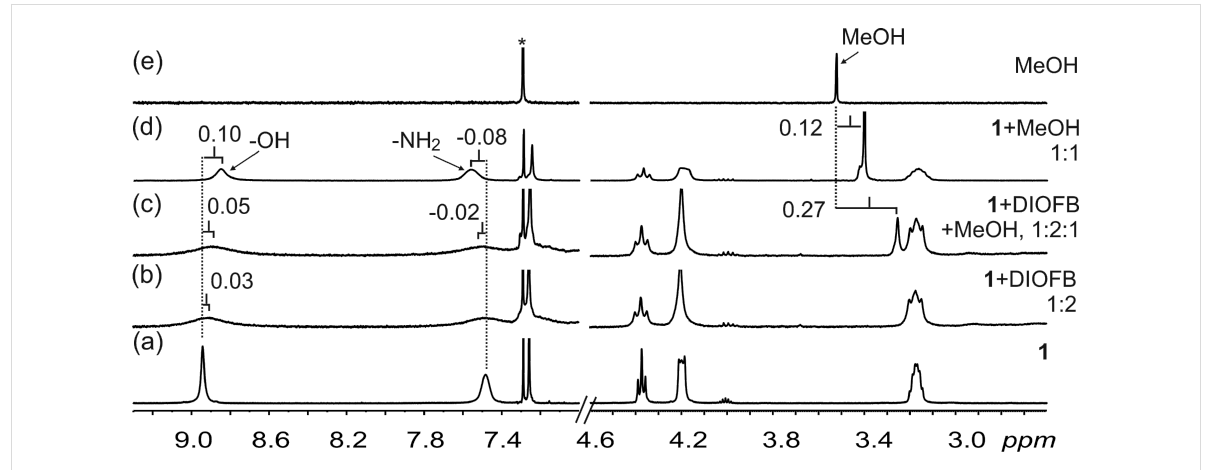
Figure 6: 1 H NMR in CDCl 3 at 298 K of: a) 1 (10 mM), b) 1:2 mixture of 1 and DIOFB, c) 1:2:1 mixture of 1 , DIOFB and MeOH, d) 1:1 mixture of 1 and MeOH, and e) MeOH (10 mM). The dashed lines give an indication of the signal changes in ppm. The asterisk represents the residual CDCl 3 solvent.